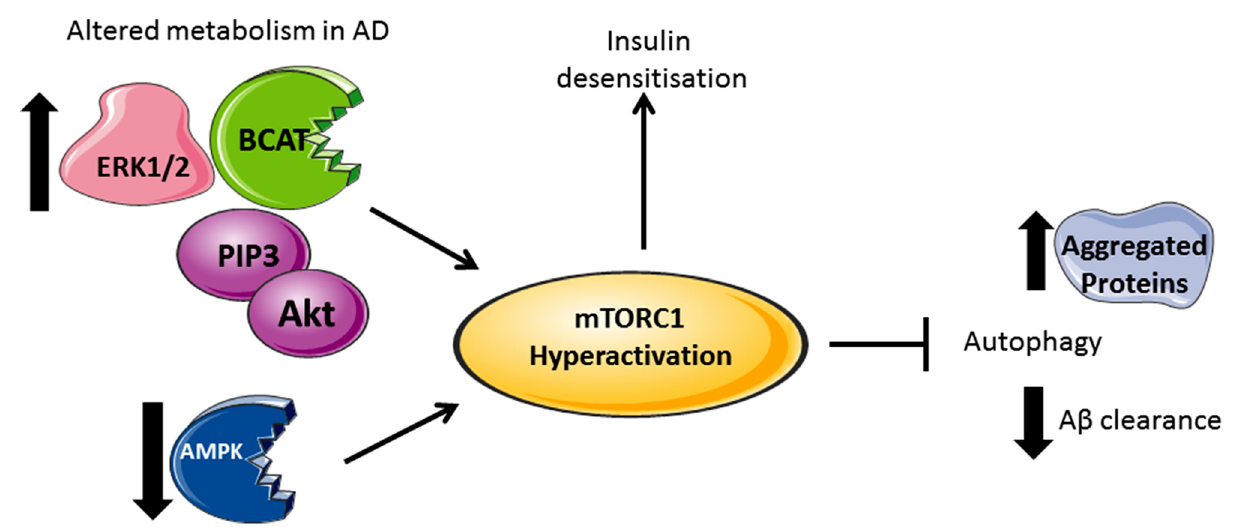
FIGURE 2 | Divergent metabolic regulation in Alzheimer’s disease (AD). In AD brain, levels of Akt, PIP3, ERK1/2, and human branched chain aminotransferase (hBCAT) are increased together with phosphorylation of mTOR at Ser248, 4EBP1, eukaryotic initiation factor 4E (eIF4E) and p70S6K. The decreased expression of PTEN, an inhibitor of PI3K/Akt signaling, further activates mTOR. Over-activation of the PI3K/Akt/mTOR axis inhibits autophagy, supported by reduced levels of Beclin-1 and LC3 in the AD brain, thus reducing aggregate clearance including A β . Accumulative A β levels, alongside increased p70S6K, cause phosphorylation and inhibition of IRS1 instigating insulin desensitization. mTOR hyperactivation and the associated changes in metabolic proteins correlate with tau pathology and cognitive